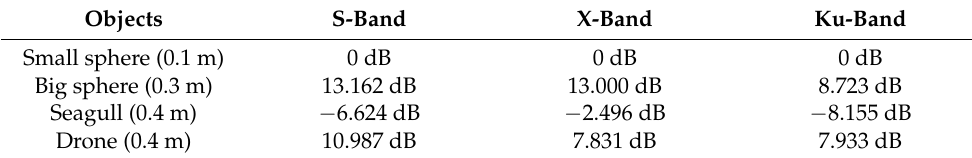
Table 3. Relative values of radar scattering power of different